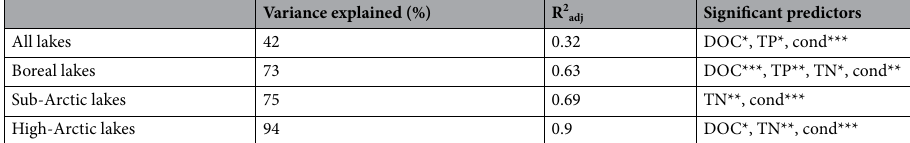
Variance explained (%) R 2